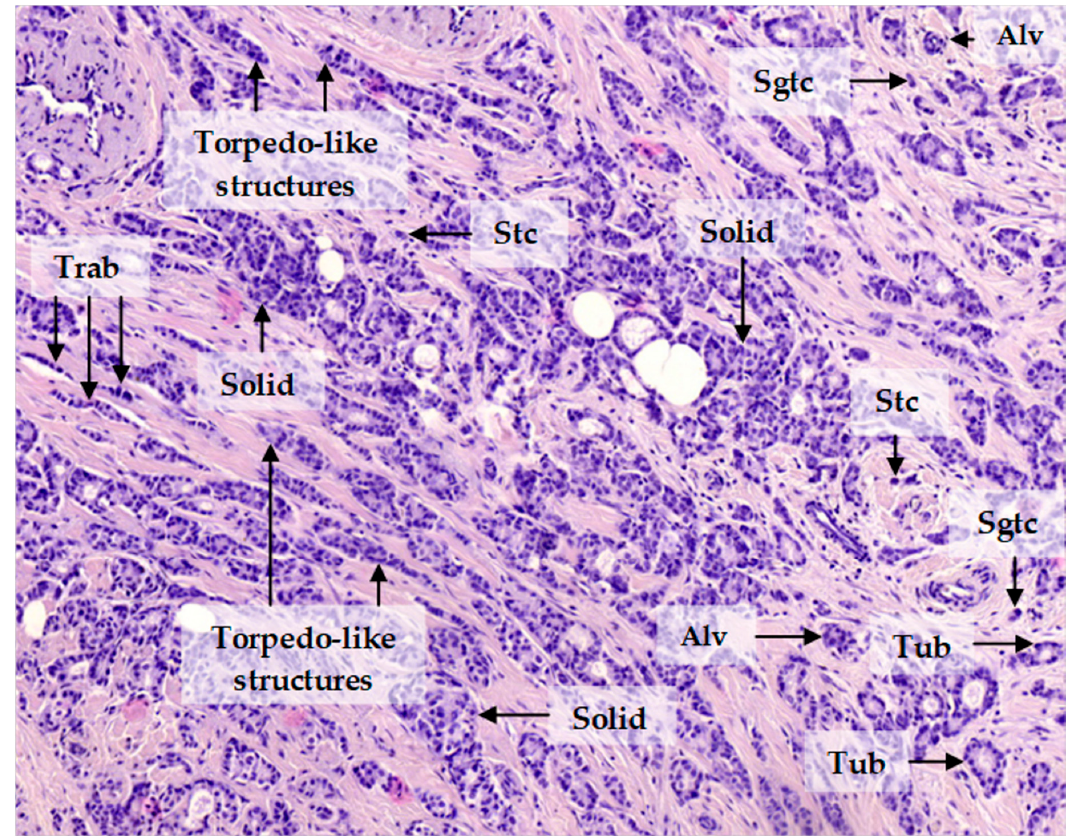
Figure 1. Invasive breast carcinoma of no special type. The invasive component of the tumor is heterogeneous and represented by tubular (Tub), alveolar (Alv), solid, trabecular (Trab), and torpedo-like structures, as well as discrete groups of tumor cells including small groups of two to five tumor cells (Sgtc) and single tumor cells (Stc). Hematoxylin and eosin staining, 200× magnification.